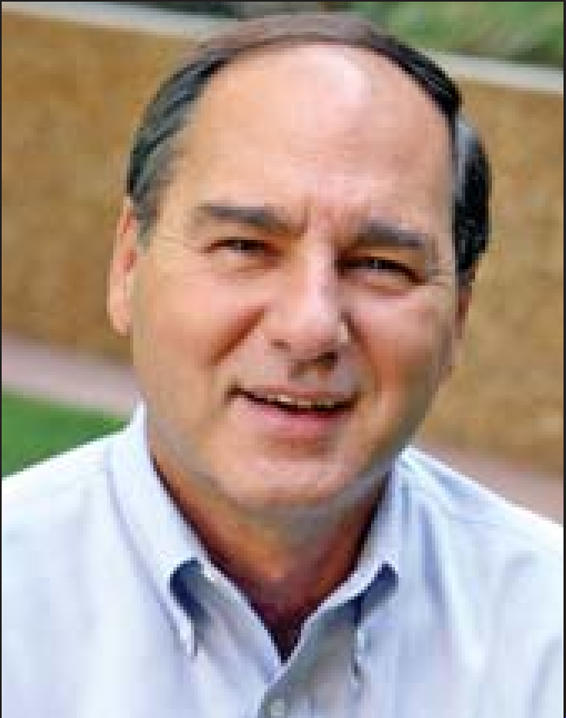
Kenneth S. Korach